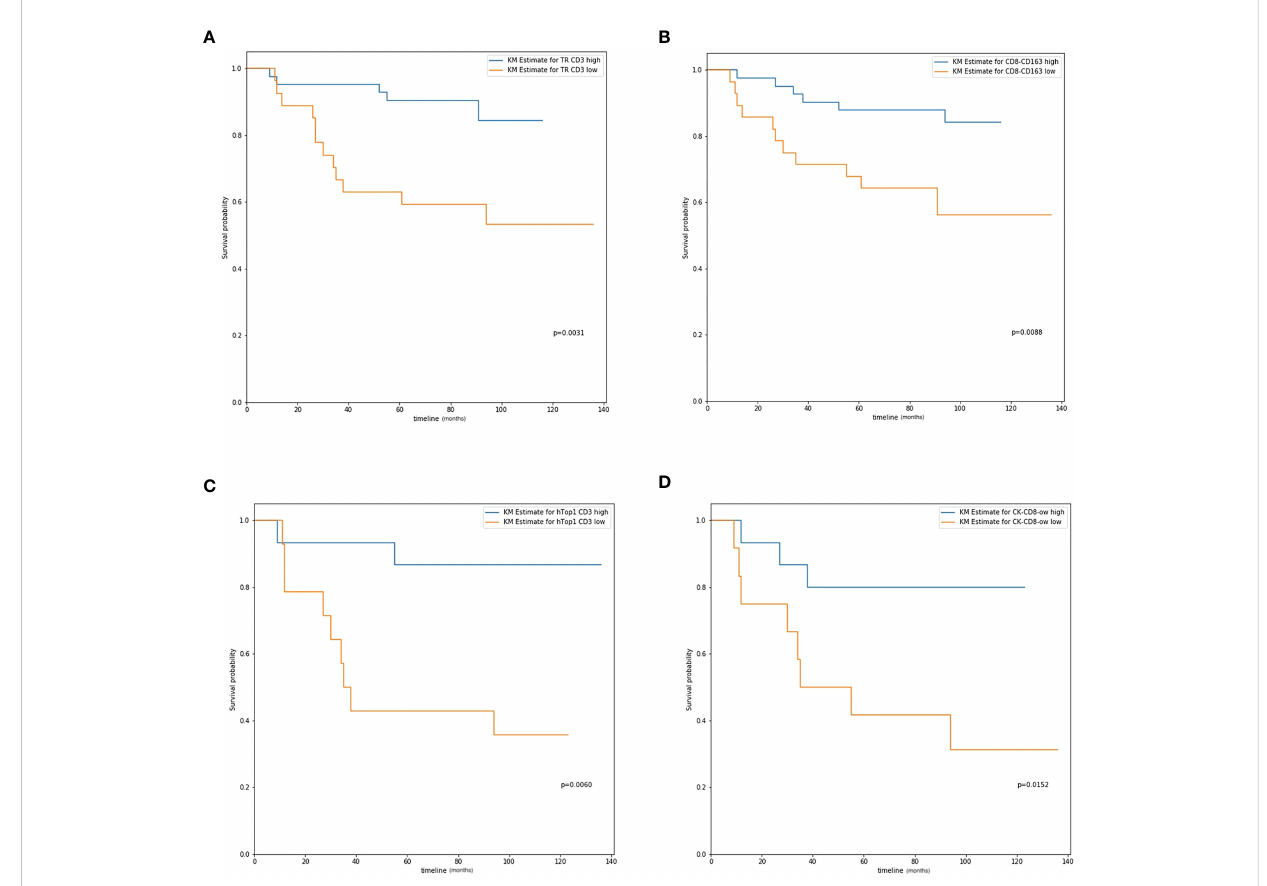
FIGURE 3 The overall survival curve. (A) CD3 expression in tumor region in all patients; (B) CD8-CD163 colocalization level in all patients; (C) Hotspot 1 CD3 expression in IIB and III stage patients; (D) CK-CD8 colocalization level in IIB and III stage